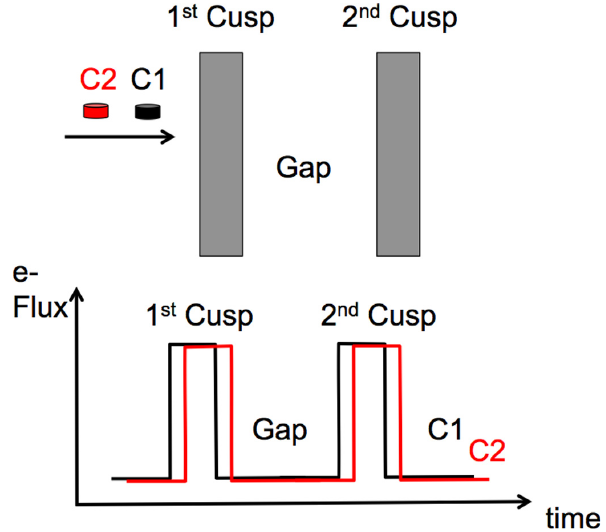
Fig. 4. Sketch of two separated cusps crossed by C1 and C2 in space (top) and the corresponding flux of electrons measured by C1 (black) and C2 (red) (bottom) as a function of